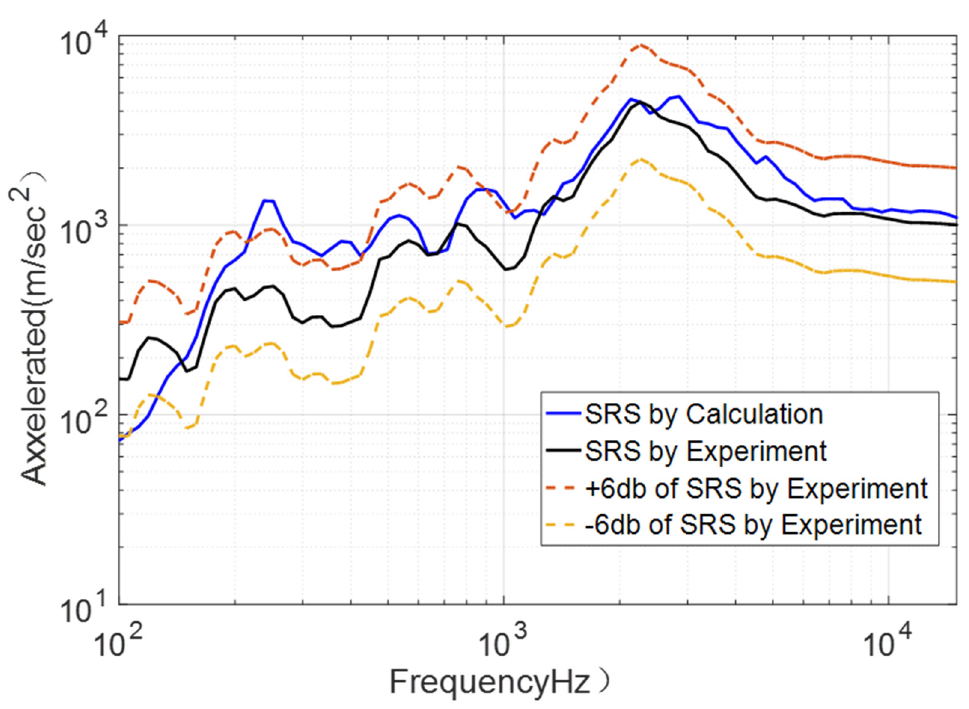
Figure 12. Shock responses of experiment and calculation for plate 3.